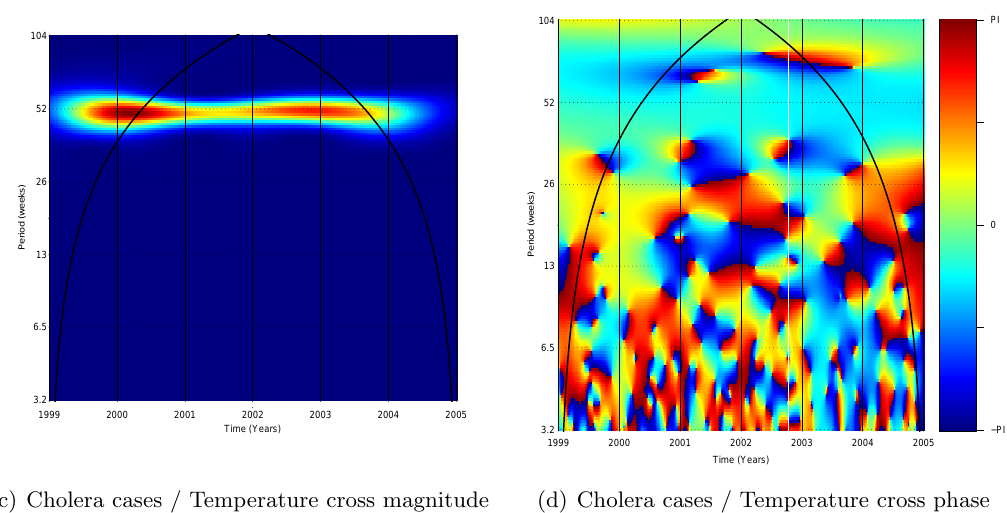
Figure 7: Cross-wavelet magnitude ( | W